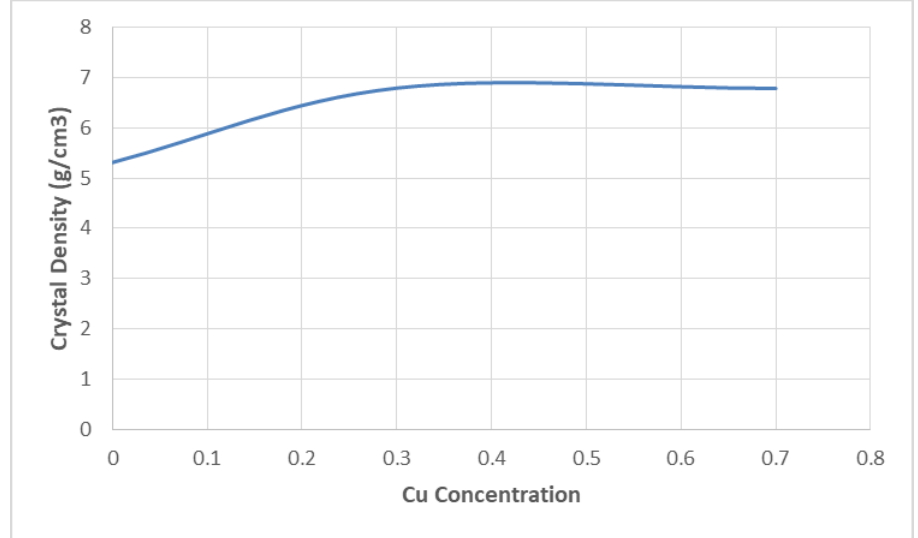
Fig.7: Variation of the crystal density with Cu +2 ions